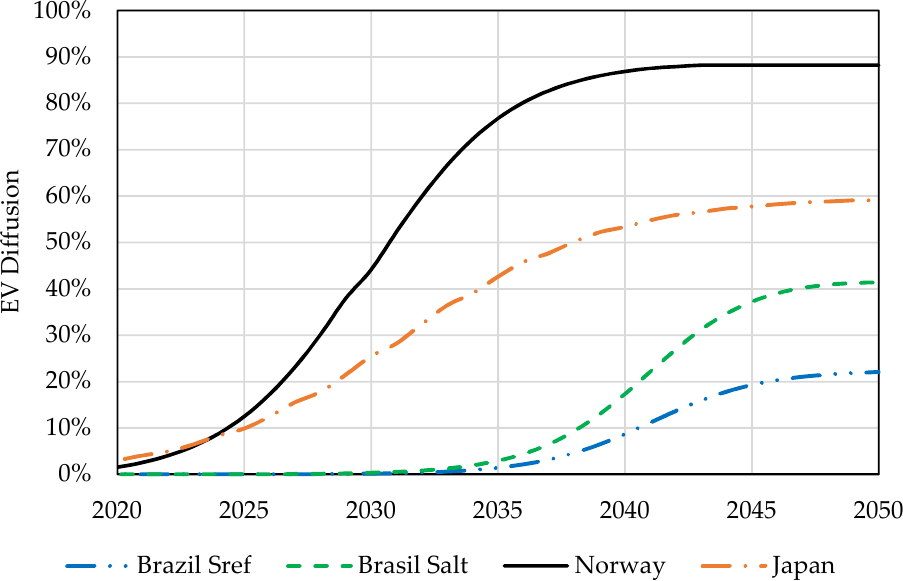
Figure 3. EV share in passenger car sales in Brazil ( S ref and S alt ), Japan, and Norway, 2020 to 2050.